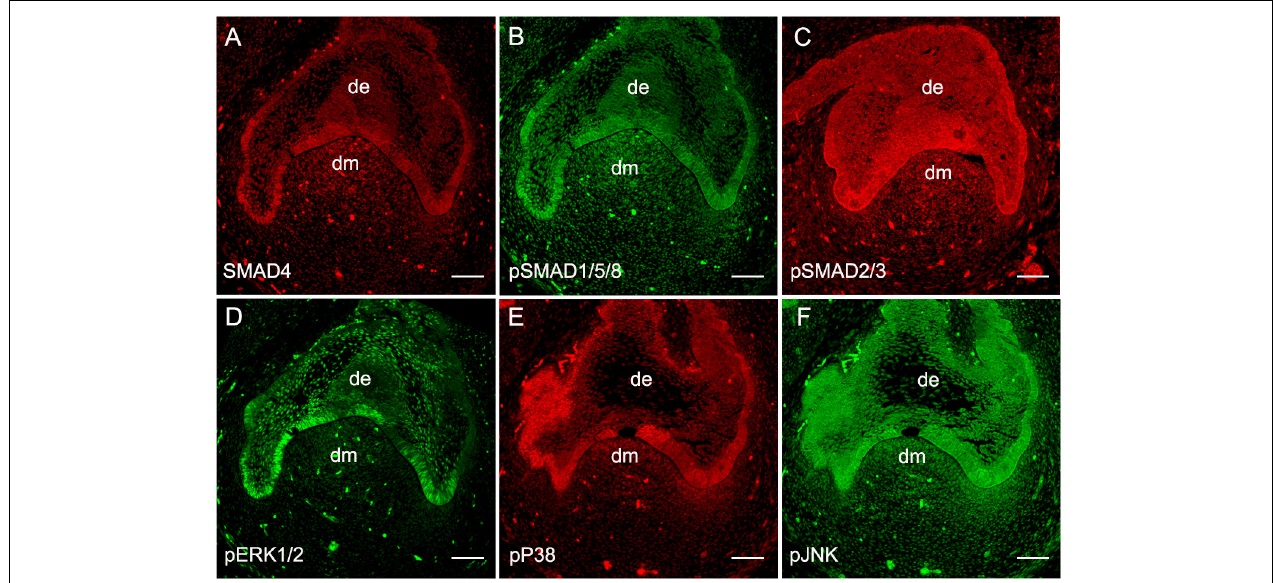
FIGURE 1 | Expression of BMP intracellular signal transducers at the human cap-stage tooth germ. (A–C) Expression of SMAD signal transducers: SMAD4 (A) , pSMAD1/5/8 (B) , and pSMAD2/3 (C) . (D–F) Expression of MAPK signal transducers: pERK1/2 (D) , pP38 (E) , and pJNK (F) . de, the dental epithelium; dm, the dental mesenchyme. Bar = 50 µ m.